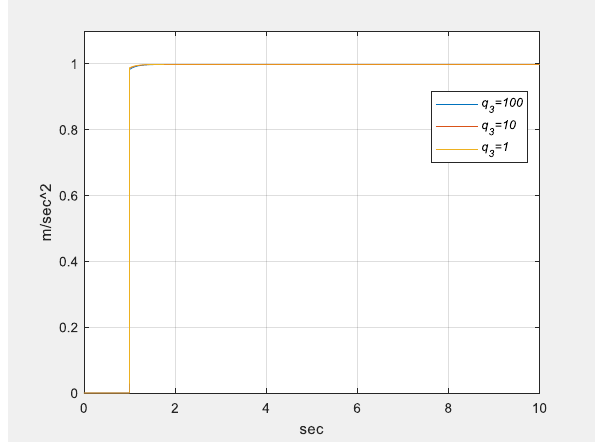
Figure 22. Influence of q 3 on specific force, q 1 = 100, and β 1 = 1.